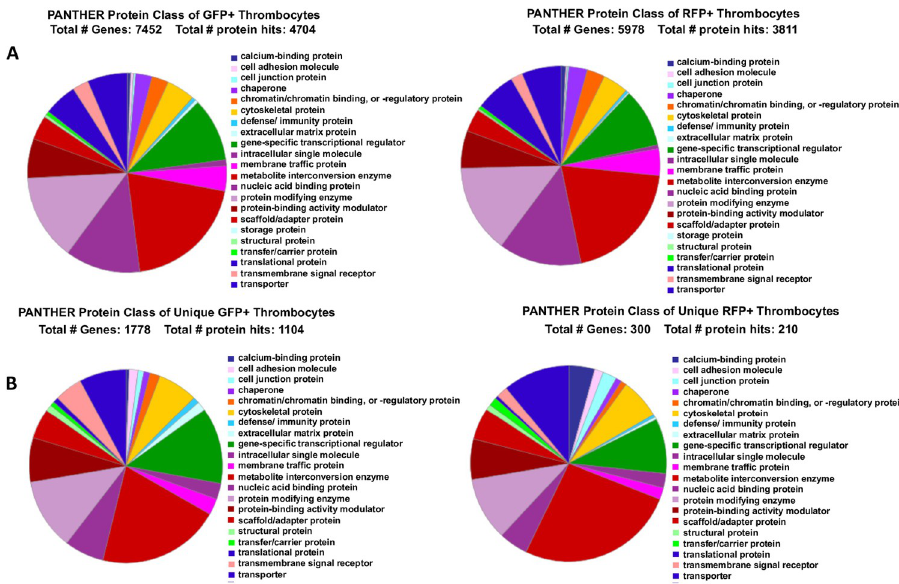
Fig 1. PANTHER analysis and classification of GFP+ and RFP+ thrombocyte transcripts. A. When 8,746 genes expressed in GFP+ and 6990 genes expressed in RFP+ thrombocytes were uploaded into the PANTHER program, and Danio rerio species was selected, GFP+ 7452 genes and RFP+ 5978 genes, respectively were detected by this program. The program yielded a total number of protein hits of 4704 and 3811 for these GFP+ and RFP+genes, respectively. B. When 2153 unique genes expressed in GFP+ thrombocytes and 397 unique genes expressed in RFP + thrombocytes were uploaded into the PANTHER program, and Danio rerio species was selected, GFP+ 1778 genes and RFP+ 300 genes, respectively, were detected by this program. The program yielded a total number of protein hits of 1104 and 210 for these unique GFP+ and RFP+unique genes, respectively. In both A and B, the percentage of each of the protein classes for GFP+ and RFP+ gene lists are shown by different colors in the pie chart, and their classification is provided by its side with similarly coded colors.